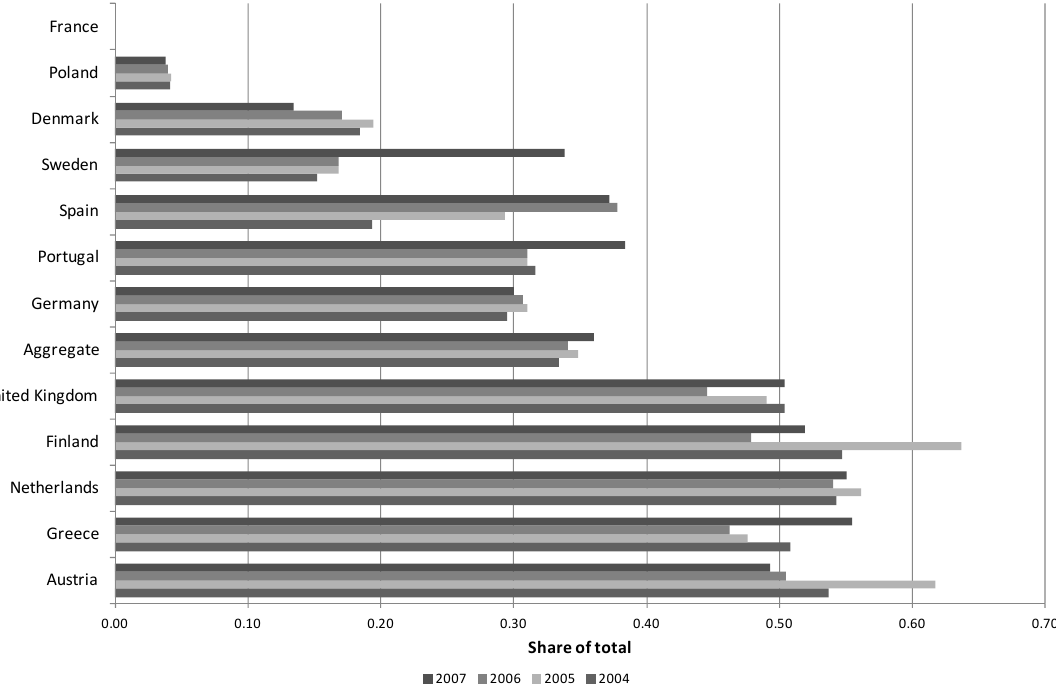
Figure 2. Shares of natural gas in fossil fuel use in power generation by country, 2004 to 2007.